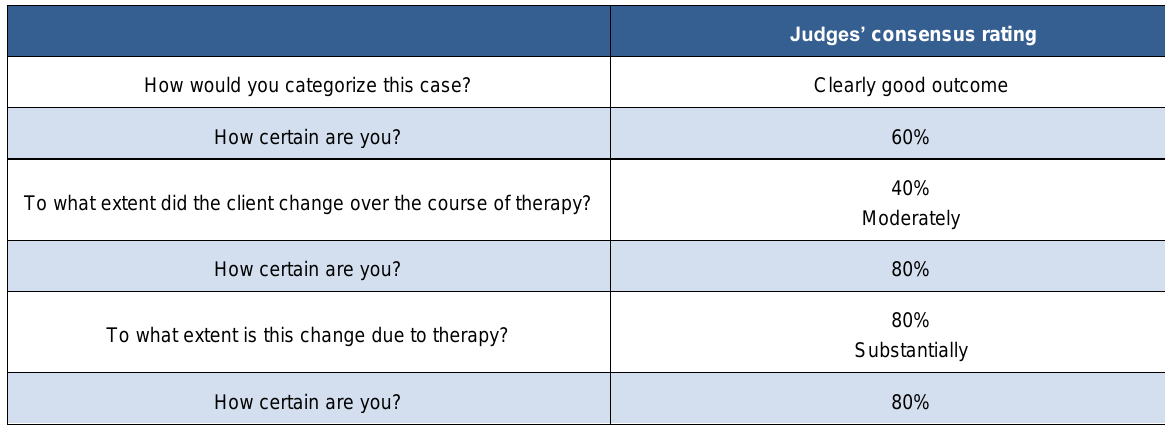
Table 5: Adjudication